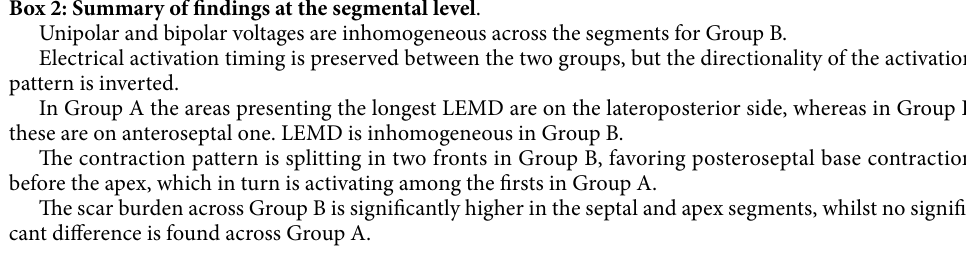
LGE intensity segmental analysis showed no difference between the two groups. In the intragroup analysis, Group B presented a significantly more burdened medioseptal segment with respect to all the other segments, except the apex and the basoseptal ones; no difference was observed across Group A. Box 2 highlights the seg- mental EM analysis findings. Box 2: Summary of findings at the segmental level . Unipolar and bipolar voltages are inhomogeneous across the segments for Group B. Electrical activation timing is preserved between the two groups, but the directionality of the activation pattern is inverted. In Group A the areas presenting the longest LEMD are on the lateroposterior side, whereas in Group B these are on anteroseptal one. LEMD is inhomogeneous in Group B. The contraction pattern is splitting in two fronts in Group B, favoring posteroseptal base contraction before the apex, which in turn is activating among the firsts in Group A. The scar burden across Group B is significantly higher in the septal and apex segments, whilst no signifi- cant difference is found across Group A.